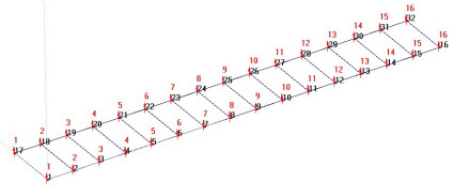
Figure 6. Layout plan of measuring points.